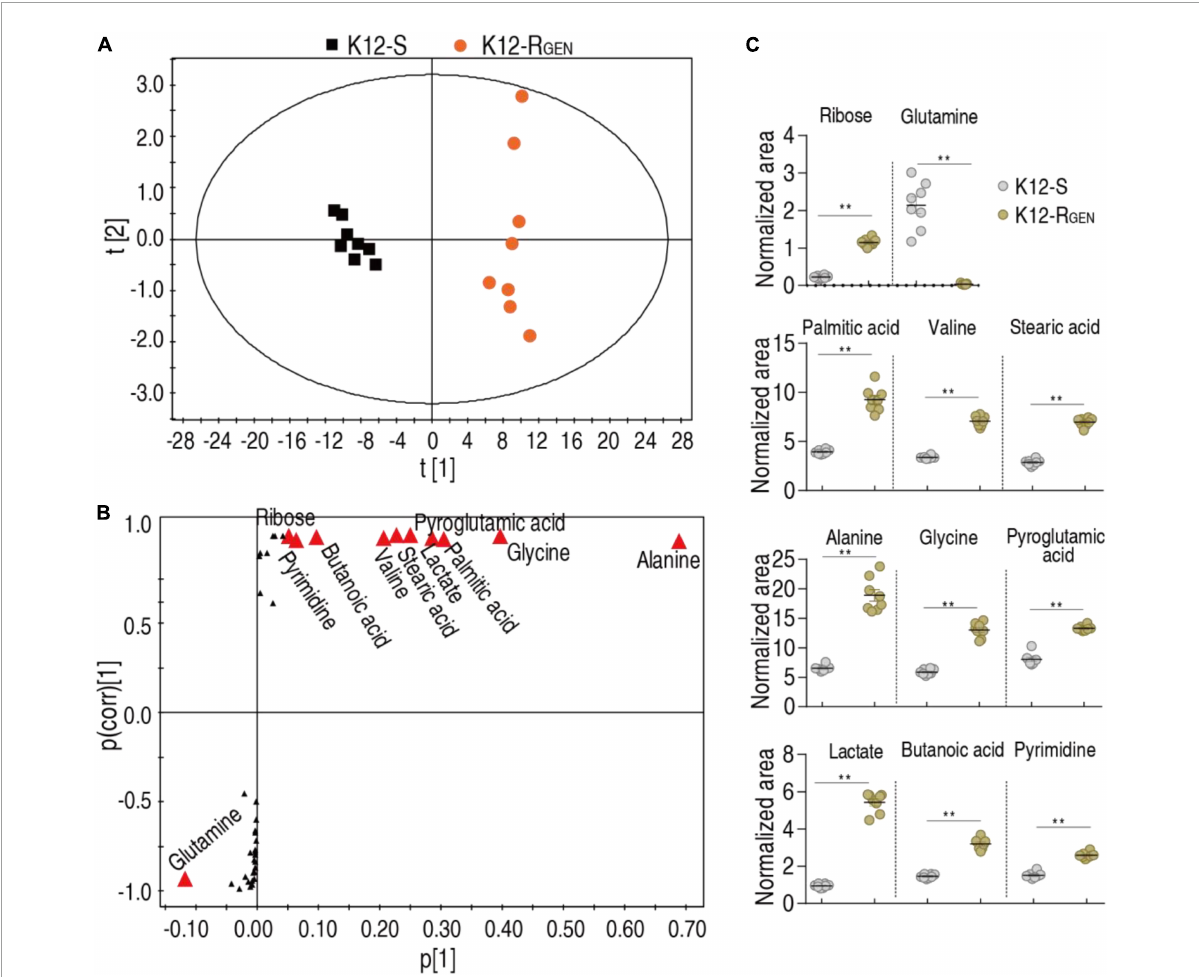
FIGURE5 Identification of crucial metabolites. (A) PCA analysis according to the treatments set. Each dot represents the technical replicate analysis of samples in the plot. (B) S-plot generates from OPLS-DA. Predictive component p [1] and correlation p(corr) [1] differentiate K12-R GEN from K12-S. The dot represents metabolites and candidate biomarkers are highlighted in red. (C) Scatter plot of biomarkers in data (B) . Results (C) are displayed as mean ± SEM, and significant differences are identified (** p < 0.01) as determined by a two-tailed Student’s t